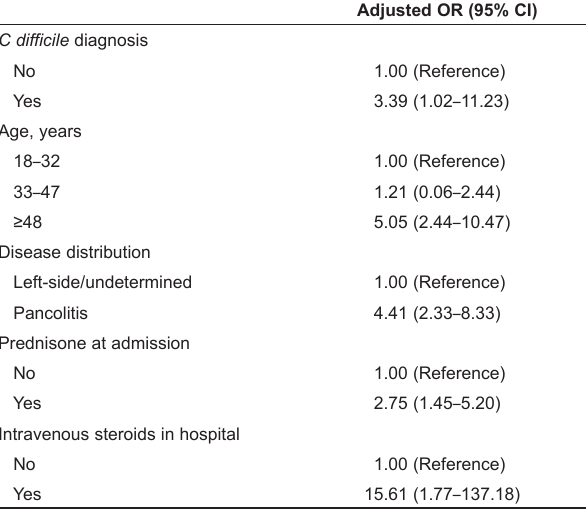
TAble 2 logistic regression results of all ulcerative colitis patients (n=278) who underwent emergent colectomy with Clostridium difficile diagnosis as primary exposure